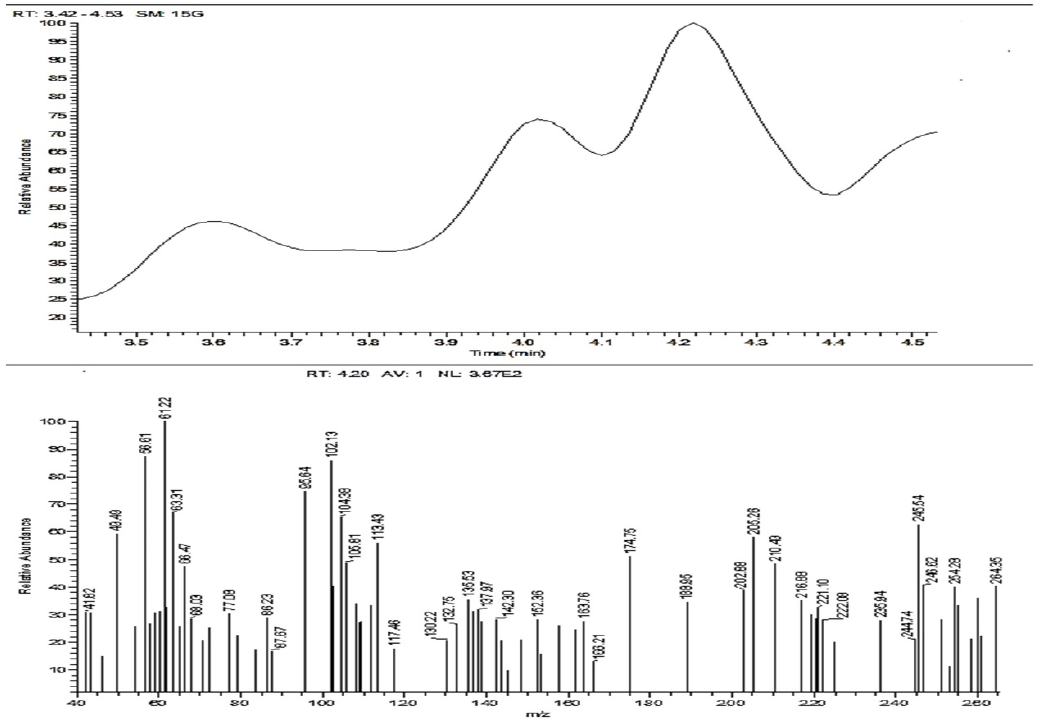
Figure 7. Mass Spectroscopy of ACR-3.